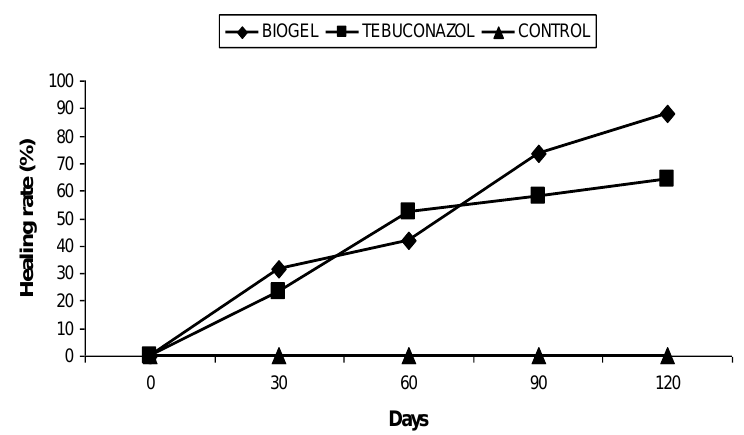
Figure 2. Effect of biogel application on apple canker in the R’Haouat orchard.